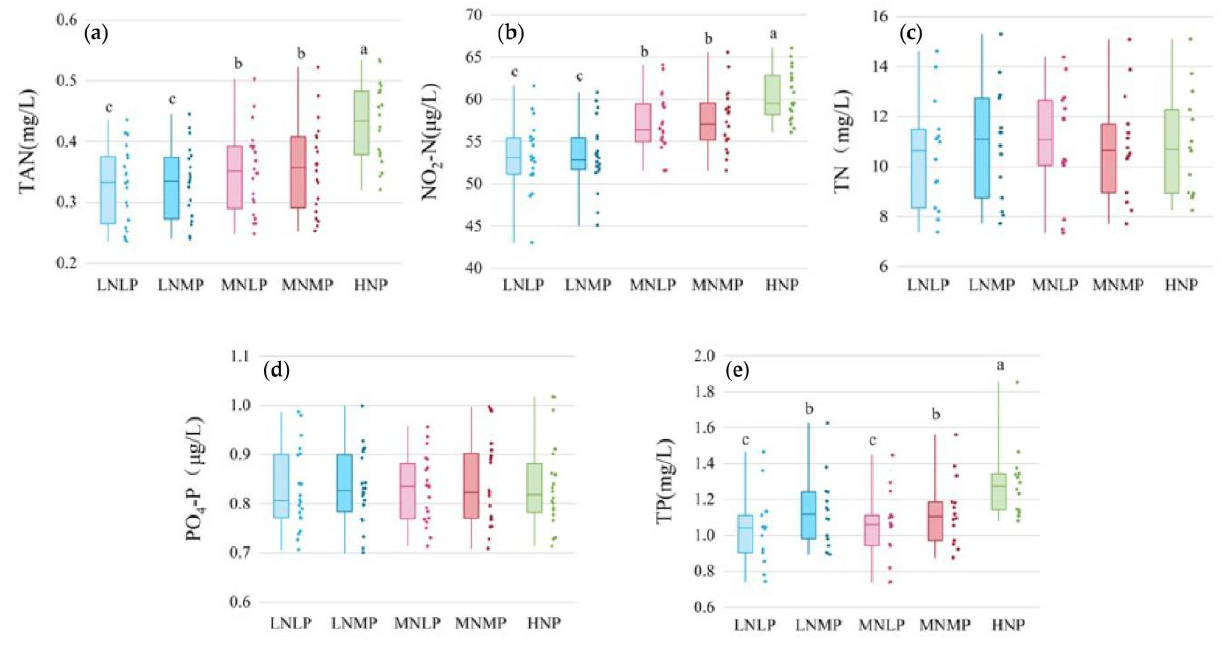
Figure 3. Boxplots for the water quality parameters of the five experimental groups within 8 weeks. ( a ) Total ammonia nitrogen, ( b ) nitrite nitrogen, ( c ) total nitrogen, ( d ) labile phosphate, and ( e ) total